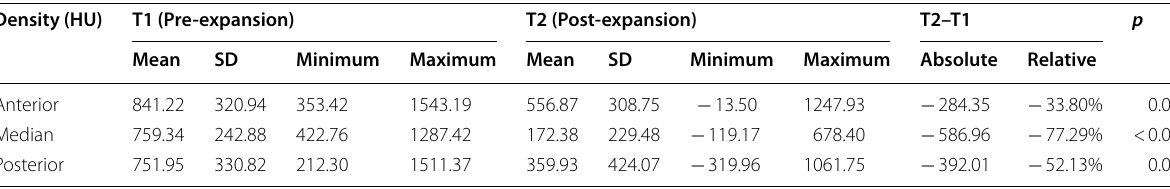
*Statistically significant at p < 0.05